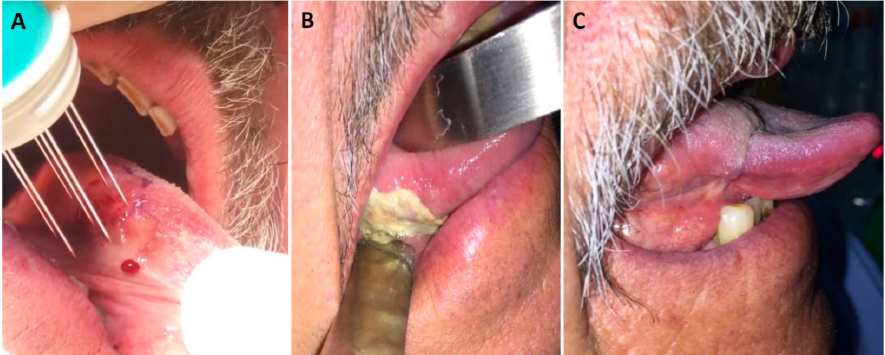
Figure 2. ( A ) A 69-year old patient with cT1N0M0 squamous cell carcinoma on the lateral surface of the mobile tongue. Electric pulses were delivered through hexagonal electrodes 8 min after in- travenous injection of bleomycin (15,000 IU/m 2 ). ( B ) Necrosis with fibrin plaque formation two weeks after ECT. ( C ) Complete response and scar formation one year after